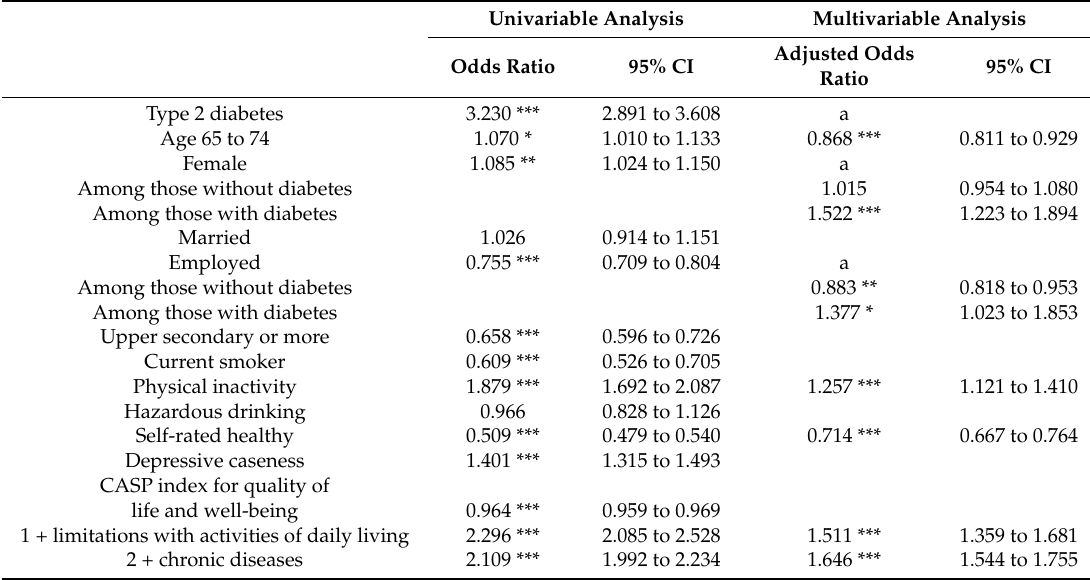
Table 2. Associations of sociodemographic, behavioral risks and health characteristics variables with obesity from multilevel (random intercept) univariable and multivariable logistic regression with individuals nested in countries (Odds Ratios < 1 are associated with decreased probability of